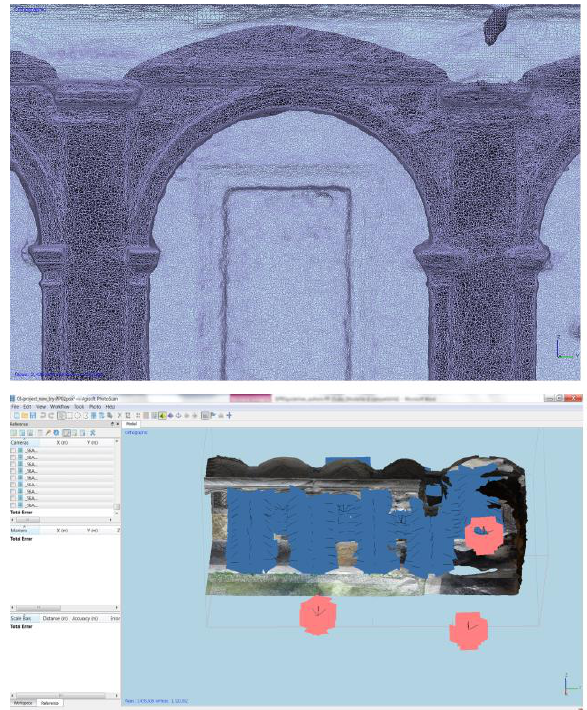
Figure 6. Frontal view of triangulated mesh, shadowed the vaults intrados profile. In pink the 360° shots, in blue the groups of single pictures